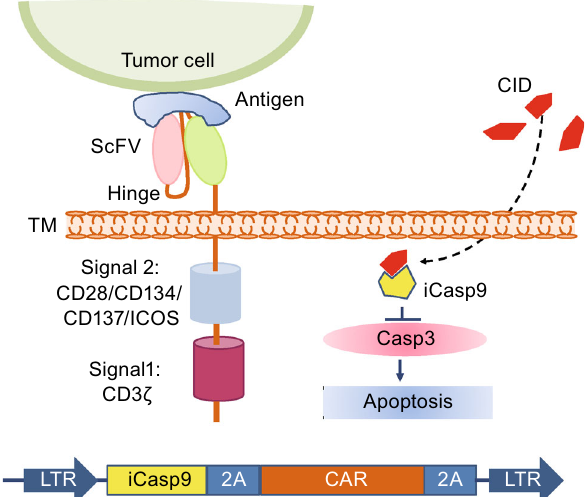
Figure 3. Armed CAR Tcell with “ OFF switch, ” suicide gene — iCasp9 to kill itself by apoptosis. The iCasp9 gene and CAR gene are linked by the 2A sequence in the CAR vector, and therefore, iCasp9 is co-expressed with the CAR molecule in CAR T cells. Once the small molecule dimerizer chemical inducer of dimerization (CID) AP20187 is added, it binds to iCasp9, triggering apoptosis. iCasp9, inducible suicide gene caspase-9; Casp3, caspase-3; ScFv, single chain variable fragment; ICOS, inducible Tcell costimulator; LTR, long terminal repeats; TM,